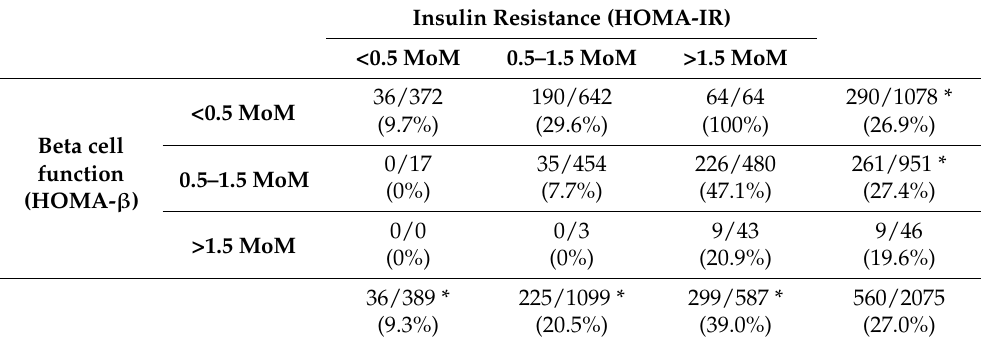
Table 2. Percentage of women with an abnormal glucose tolerance test (as diagnosis of GDM) related to HOMA-IR and HOMA- β .